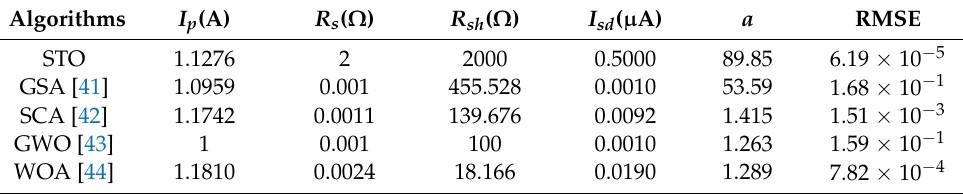
Table 5. Comparison of the STO with other parameter estimation methods for the SS2018 PV